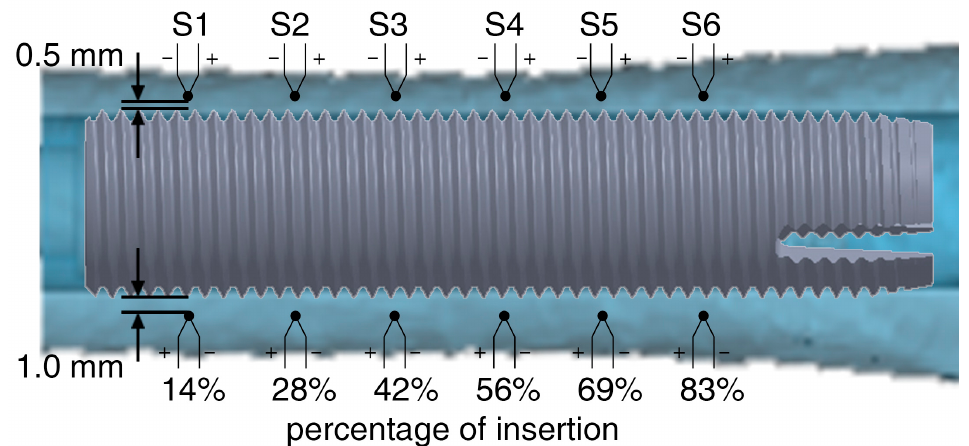
Figure 3. Position and labeling of 12 thermocouples within the bone cortex and at different insertion depths in respect to the fixture’s final position. S1 represents the most distal and S6 the most proximal thermocouple.